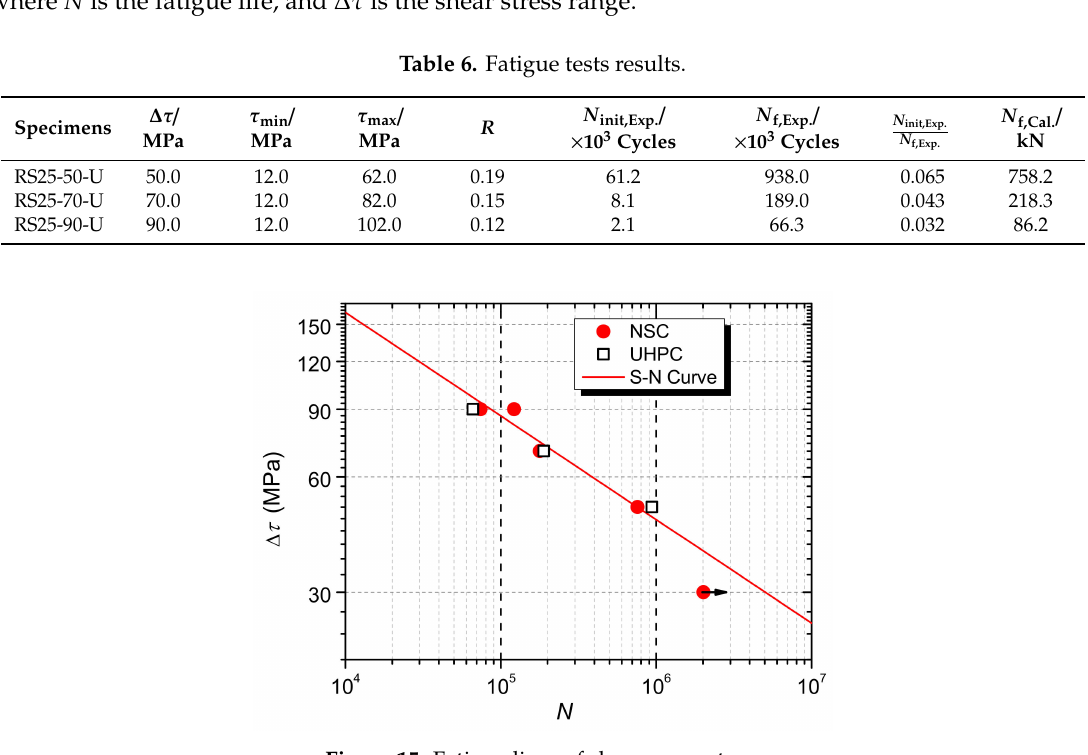
Figure 15. Fatigue lives of shear